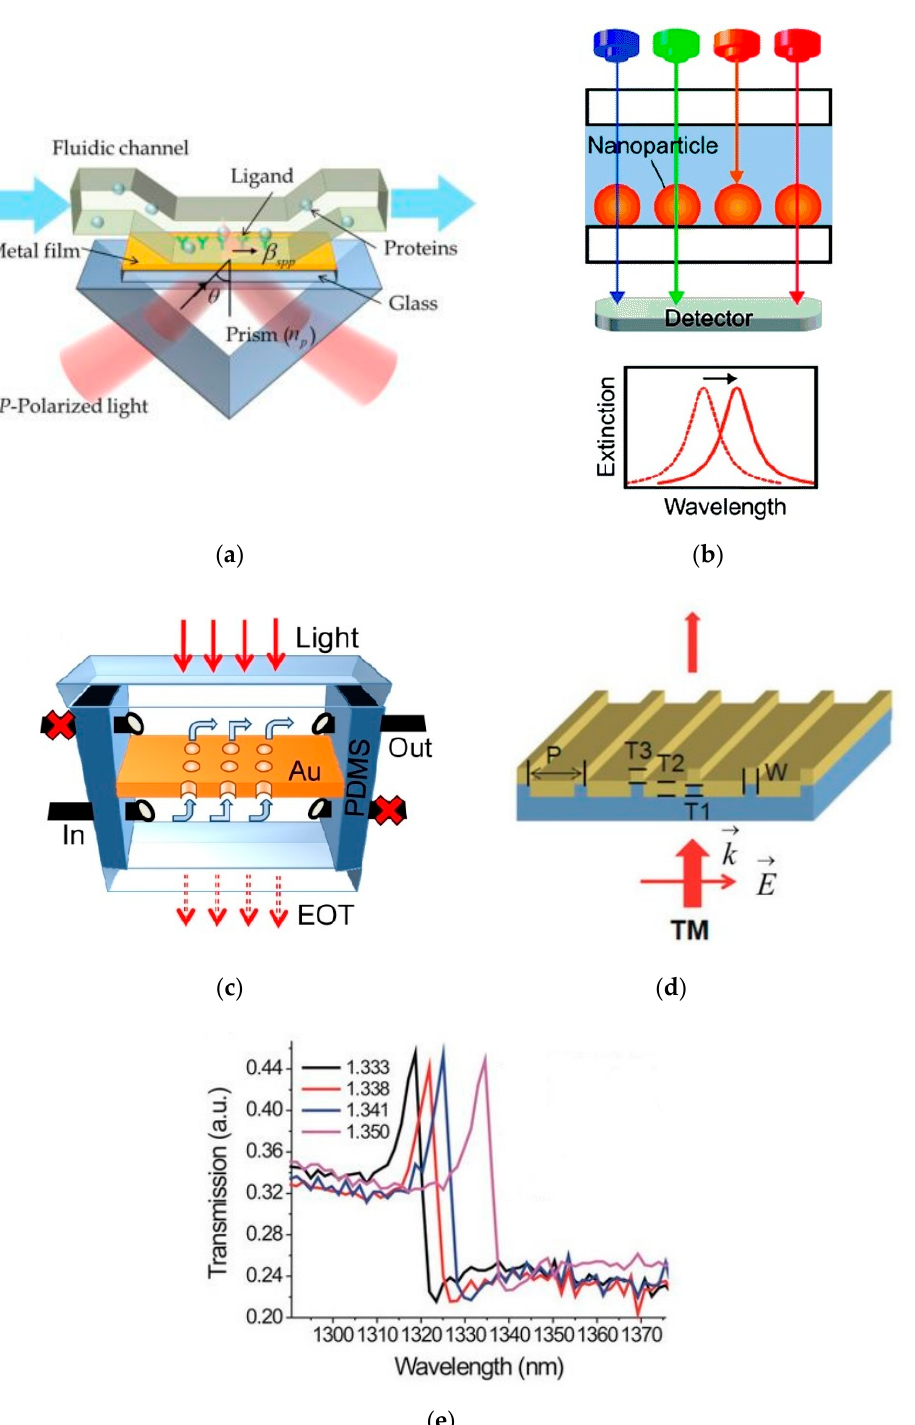
Figure 2. Schematic of plasmonic sensors. ( a ) Surface plasmon resonance (SPR) sensor requiring prism coupling. Reprinted from [93] under CC BY 3.0. ( b ) Localized surface plasmon resonance (LPSR) based sensor composed of an array of metallic nanoparticles. Reprinted with permission from [110] under CC BY-NC 3.0. Copyright © The Royal Society of Chemistry (RSC) (2014). ( c ) An array of metallic nanoholes operating on the principle of extraordinary optical transmission (EOT). Reprinted with permission from [111]. Copyright © SPIE (2010). ( d ) Schematic of plasmonic structures having Fano resonance. ( e ) Fano resonance shift by change of refractive indices. ( d , e ) Reprinted from [103] under CC BY 4.0.